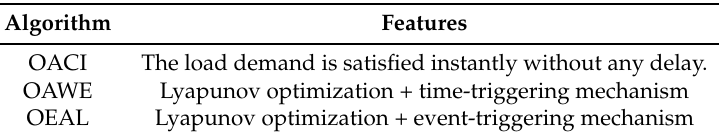
Table 3. Comparison of the three algorithms.